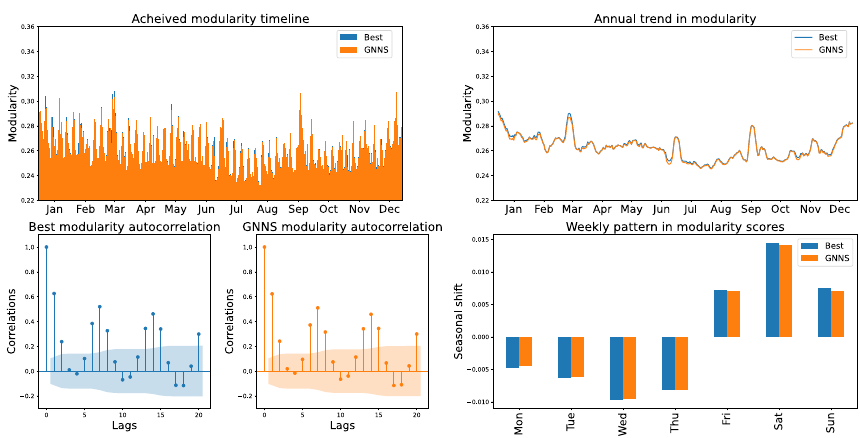
Fig. 1 Comparative performance of GNNS vs. the best of GNNS, Louvain, and Combo for community detection on the temporal network of daily taxi ridership in NYC. Subplots depict achieved network modularity and its time-series properties: autocorrelation, seasonality, and periodicity obtained by seasonal decomposition using moving